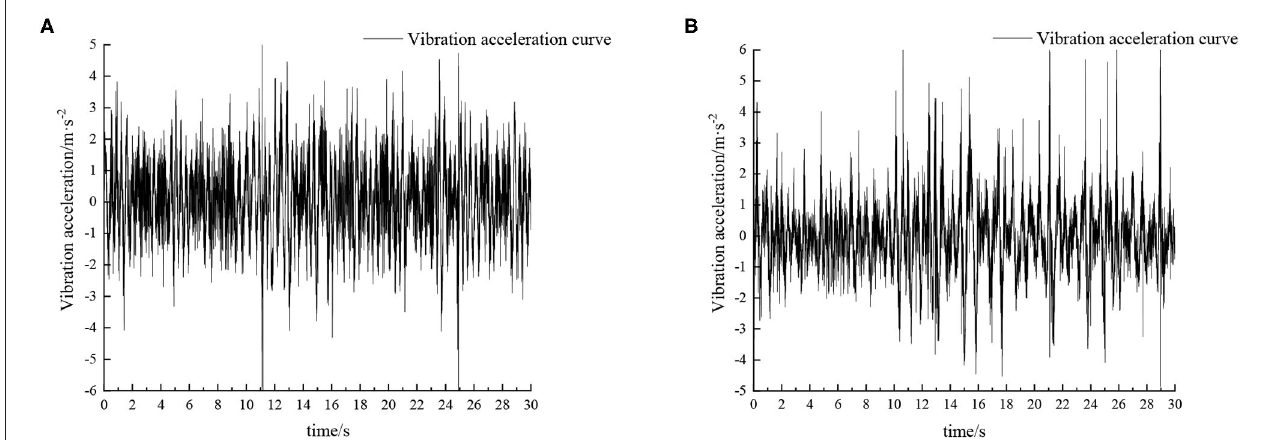
FIGURE 13 | Time domain response curve when driving at 8km/h on sand-gravel road. (A) Passive suspension. (B) Active